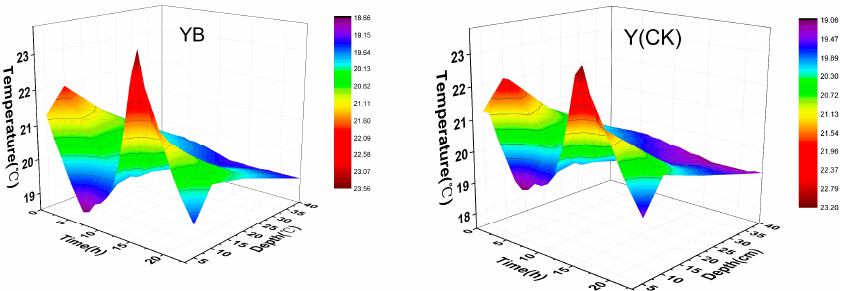
Figure 8. Temporal and spatial variation characteristics of soil temperature on different treatments.